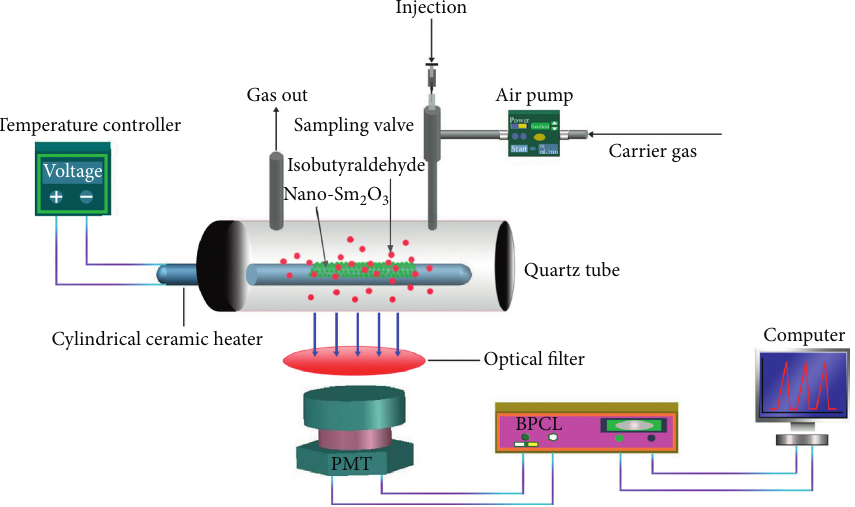
Figure 1: Schematic diagram of the CTL sensing system